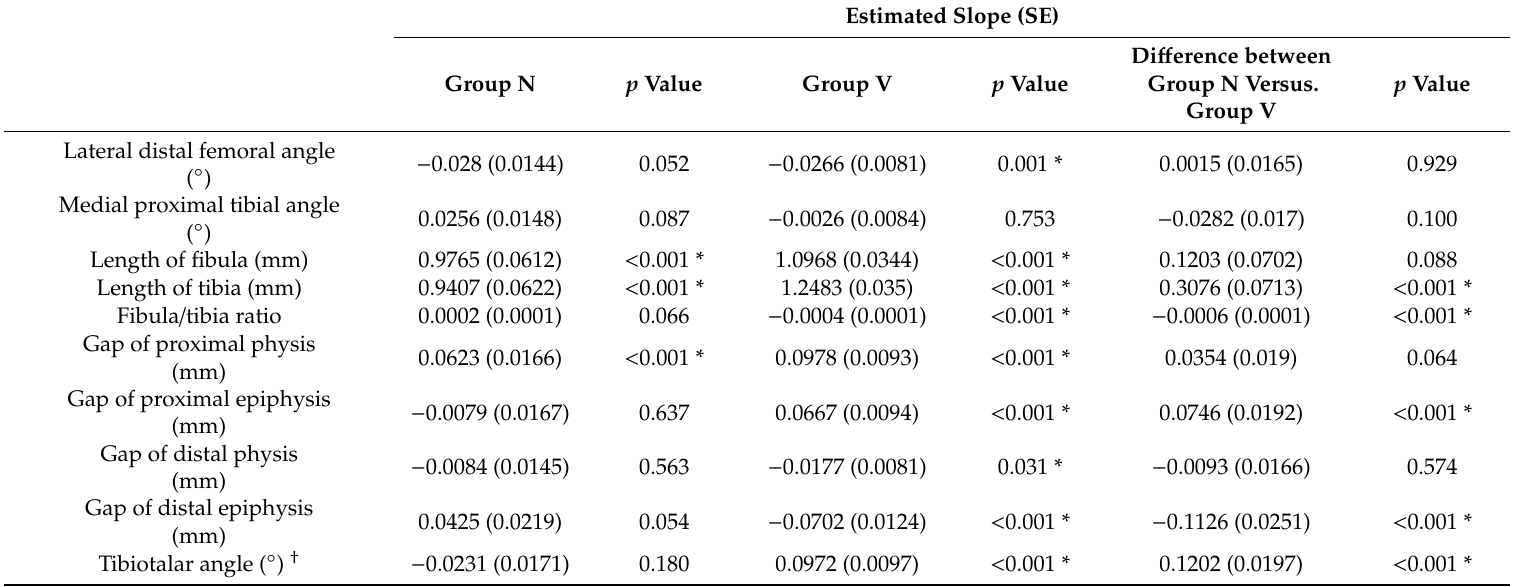
Table 3. Estimated slope of change between the initial and final